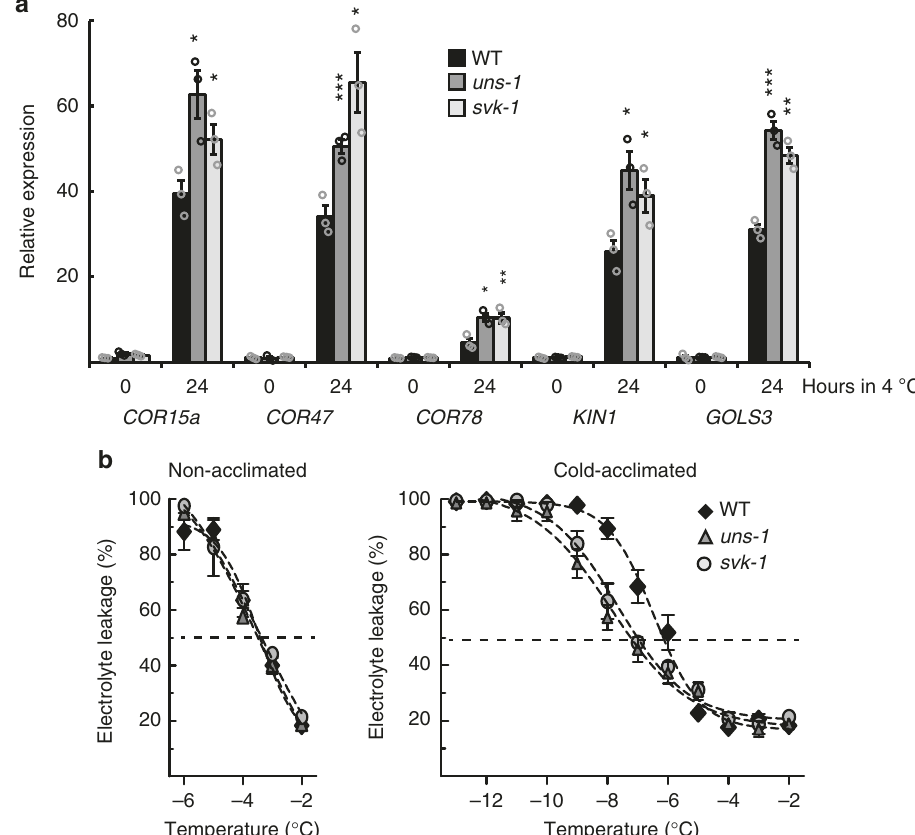
Fig. 3 Mutants that affect SVK show increased freezing tolerance. a Relative level of different cold-responsive transcripts in control and after 24 h of cold exposure in WT, svk-1 and uns-1 determined by RT-qPCR. Bars represent mean (black: WT, dark grey: uns-1 , light grey: svk-1 , ±SEM) from three biological replicates (rings). The relative level of the COR transcripts were normalized to the level in WT in control conditions. Statistically signi fi cant differences